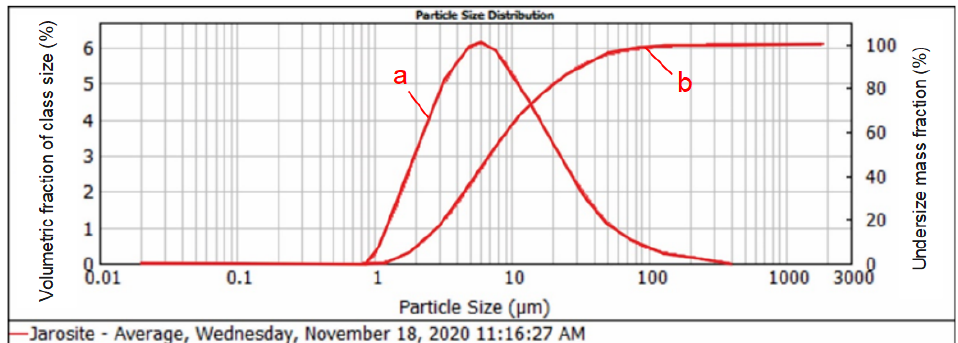
Figure 2. Graphical presentation of the identified size classes and particle size distribution of the jarosite sample: (a) incremental (direct) curve values that correspond to the left axis; (b) undersize distribution curve values that correspond to the right axis.